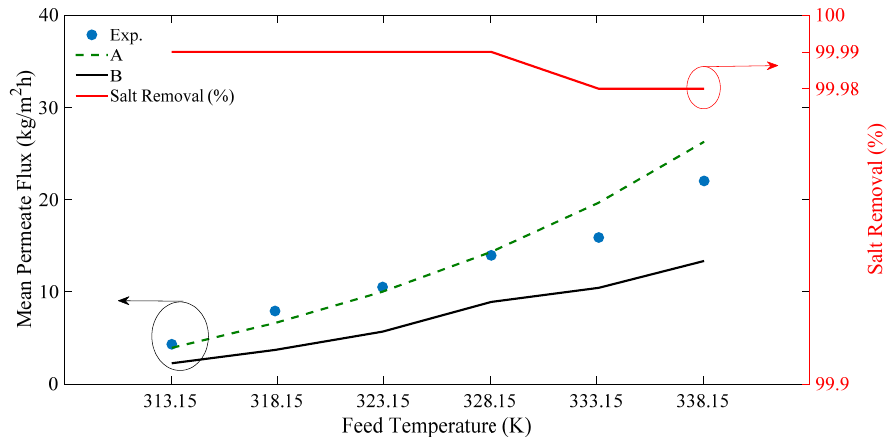
Figure 6. The permeate flux as a function of feed temperature with experimental and analytical (( A ): with spacer; ( B ): without spacer) results.